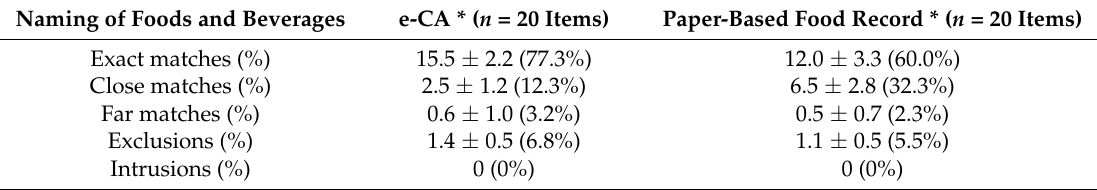
Table 2. Mean number of items ( ± standard deviation) and proportion of exact, close, and far matches, as well as exclusions and intrusions.* 11 participants used e-CA and 11 others used a paper-based food record to evaluate 20 foods and drinks displayed on a table.